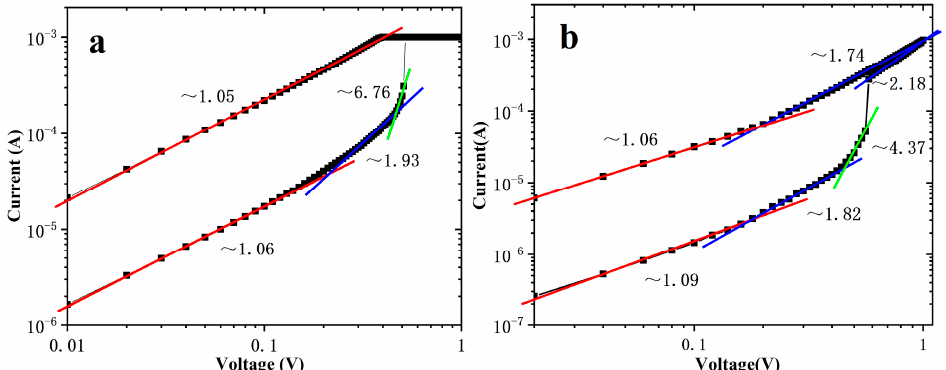
Figure 5. I-V characteristics of ( a ) Device A and ( b ) Device B in a double-logarithmic plot. The area of the devices is 2 × 2 μ m 2 and the thickness of HfO x is 10 nm.